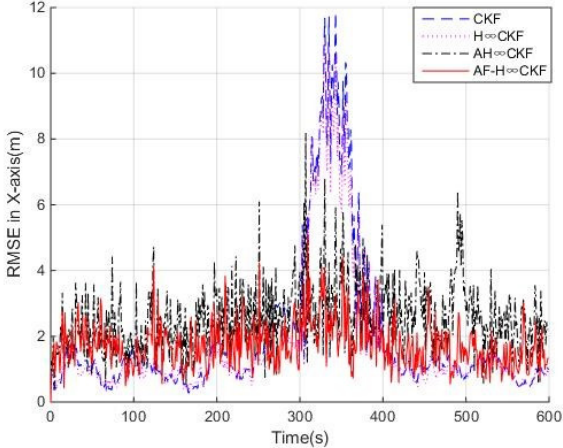
Figure 6. RMSE in the X-axis in Case 2.